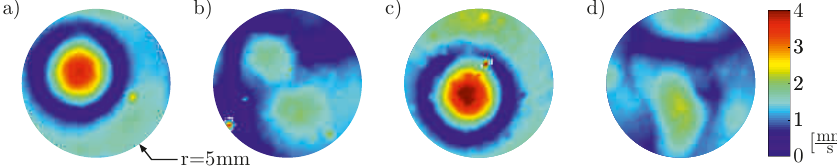
Figure 3. Maximum velocity field for simple disc-shaped transducers A and B ( a ) Baseline of A before impacting; ( b ) measurement after impacting A, leading to a transducer with cracks; ( c ) Baseline of B before impacting; ( d ) measurement after impacting B, leading to a transducer with cracks and spalling.